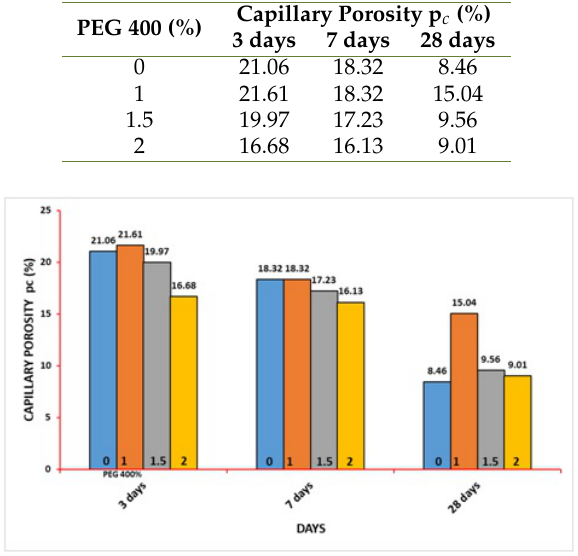
Table 5. Capillary Porosity at 0.34 Water-Cement Ratio.